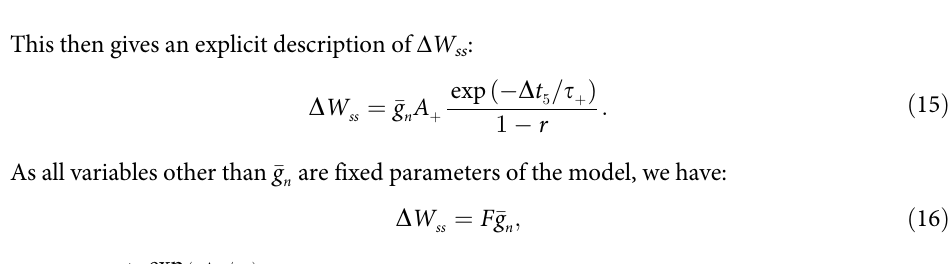
Fig 8. Coupling strength values closely trace g other closely. To enablethis comparison, they are normalized so that they have identicalmeans. All relevant parameters for both the dynamics of g n and Δ W ss are consistent with Fig